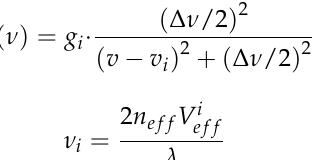
where ∆ ν , ν i and g i are the full width at half maximum (FWHM), central frequency shift and peak Brillouin gain of the i th acoustic mode-induced BGS, respectively. Additionally, V i is the effective acoustic velocity of the i th acoustic mode.